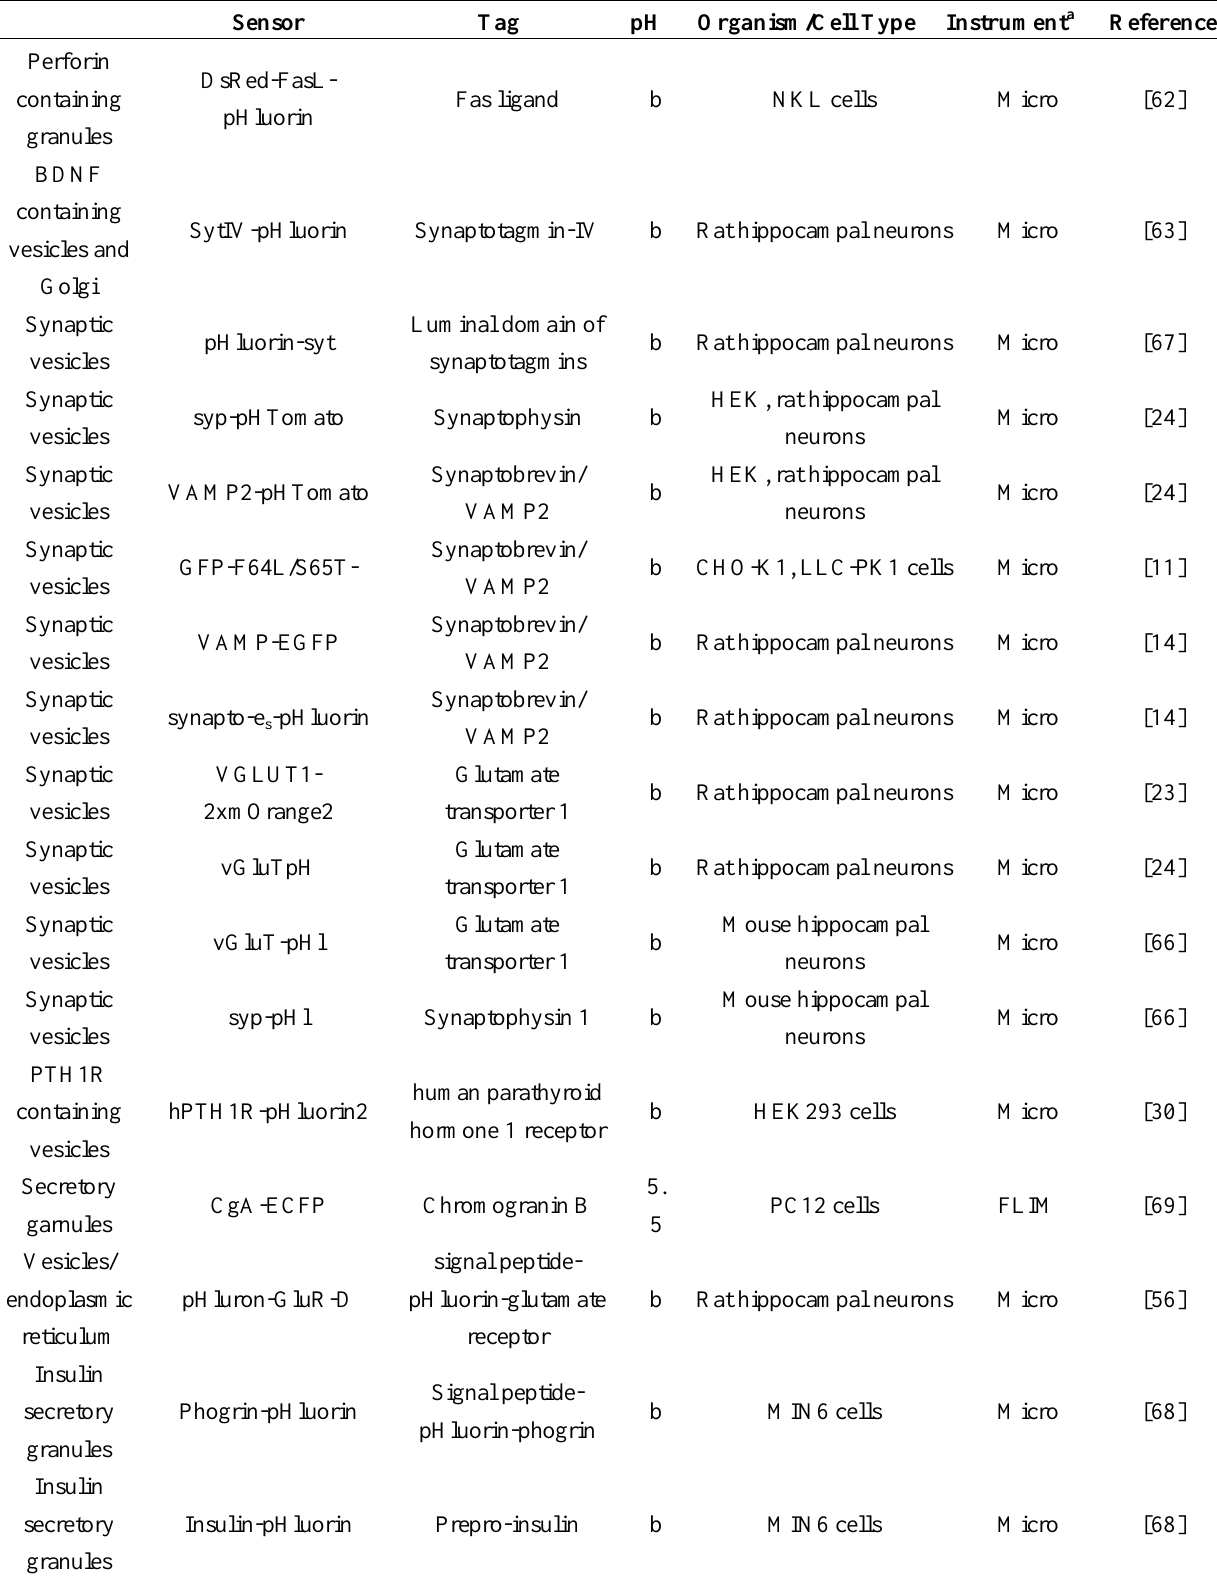
Table 6. Select examples of pH-sensitive FPs targeted to subcellular compartments of secretory and endocytic